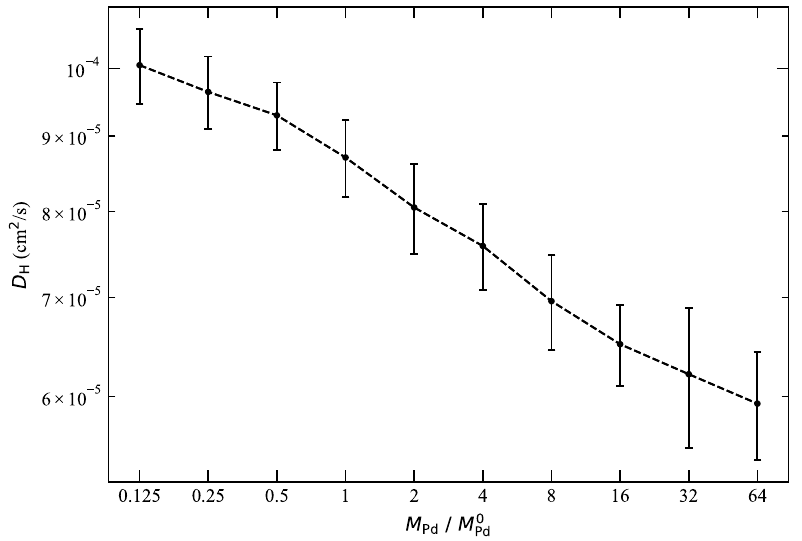
Figure 3. Calculated hydrogen diffusion coefficients in fcc Pd lattice at 500 K as a function of the ratio of a hypothetical Pd mass ( M Pd ) to the true Pd mass ( M